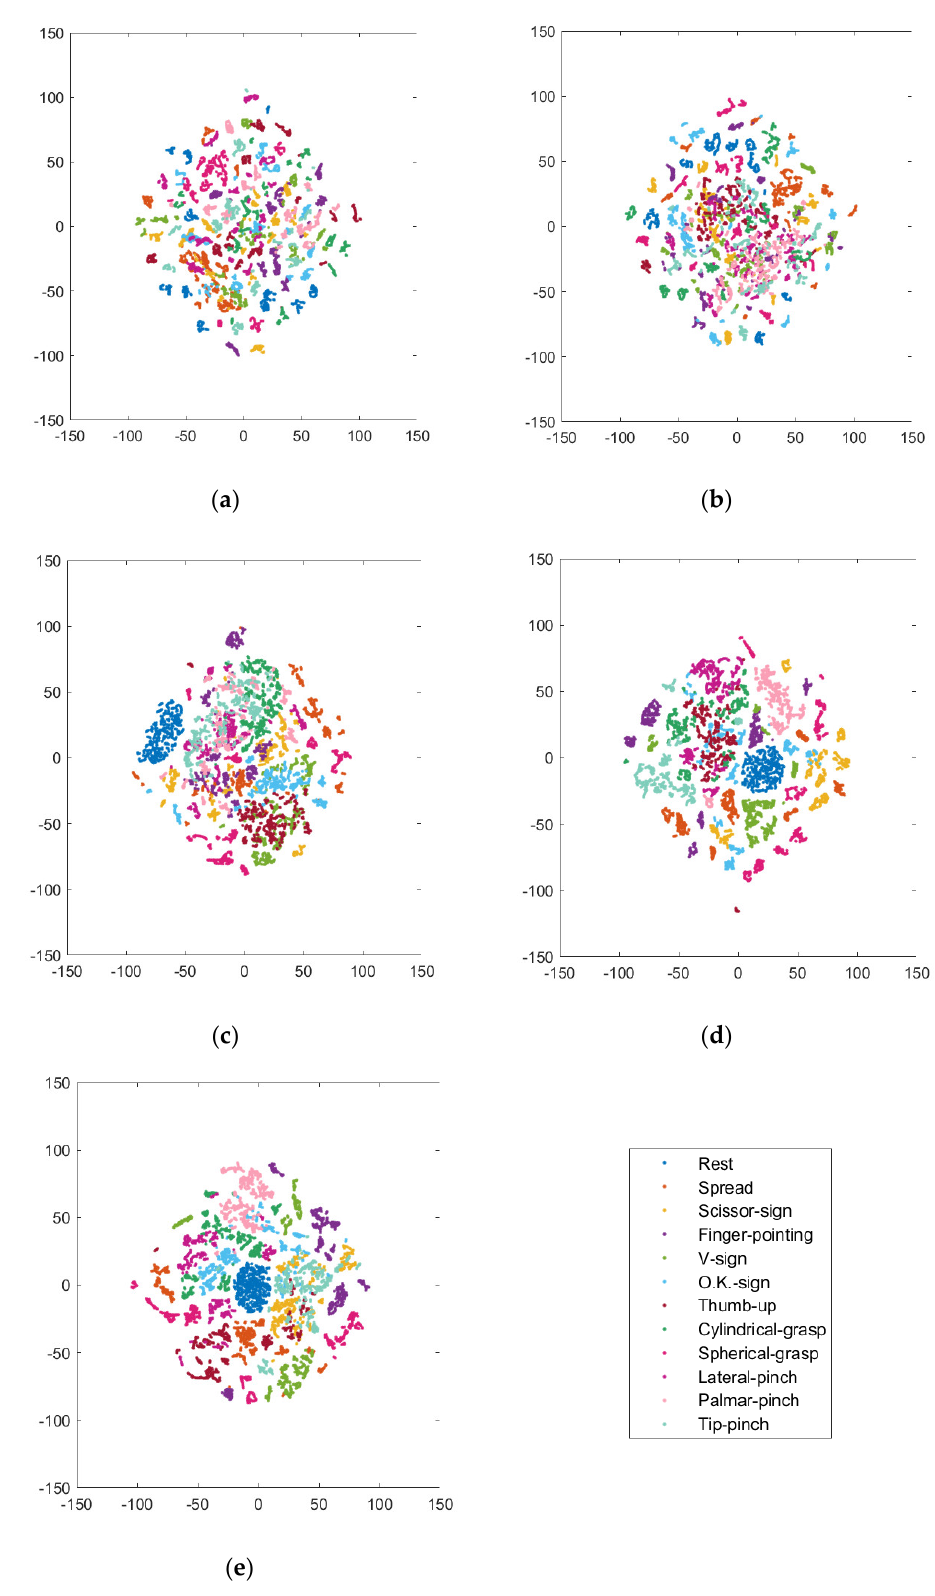
Figure 7. t-SNE visualization of variability in the forearm amputee’s sEMG signals: ( a – e ) Day 1–Day 5.